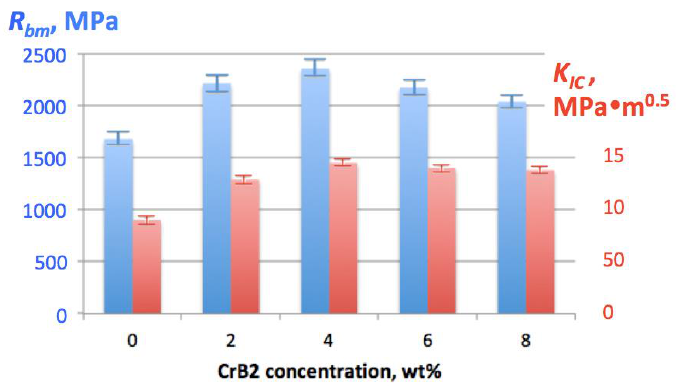
Figure 8. Dependence of the bending strength Rbm (blue) and fracture toughness K I c (red) on CrB 2 additive in the refractory matrix.